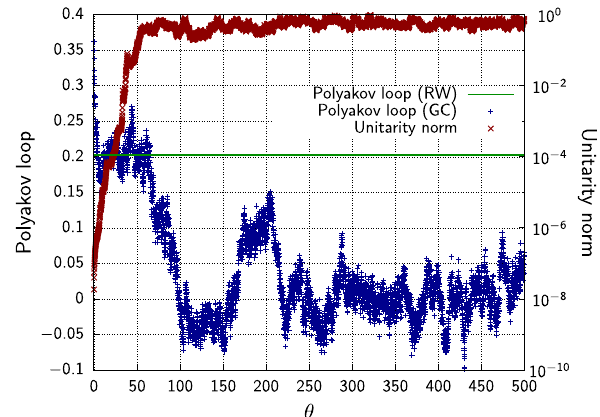
Fig. 1 The average Polyakov loop (red) and unitarity norm (green) as functions of the Langevin time for HDQCD on a 10 3 × 4 lattice, with κ = 0 . 04, β = 5 . 8 and μ = 0 . 7. Agreement with reweighting is found when the unitarity norm is lower than O ( 0 . 1 ) . The data was first presented in Ref.